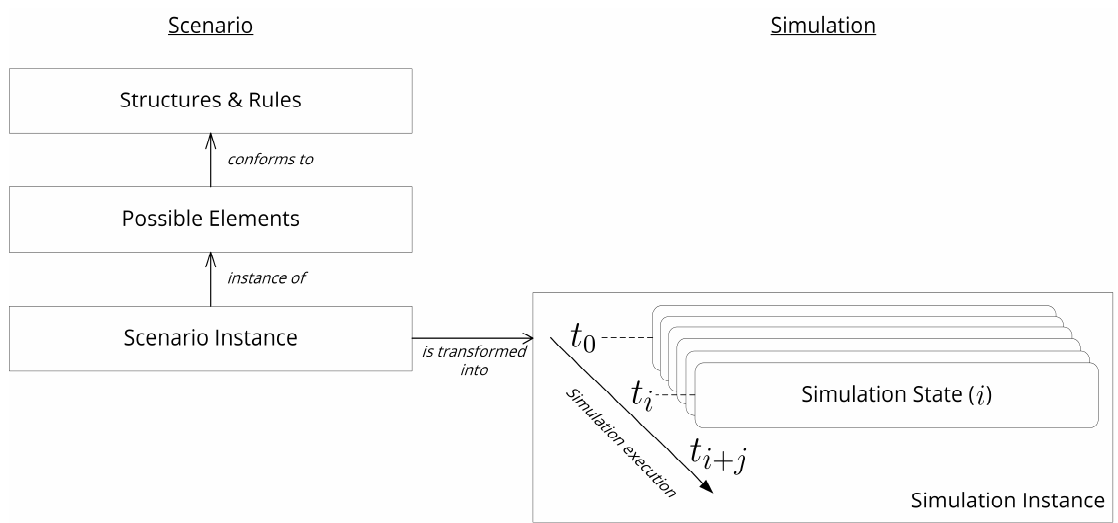
Figure 11. Possible approach to resolve dependencies between scenario and simulation. The concrete scenario instance forms the direct basis for simulation